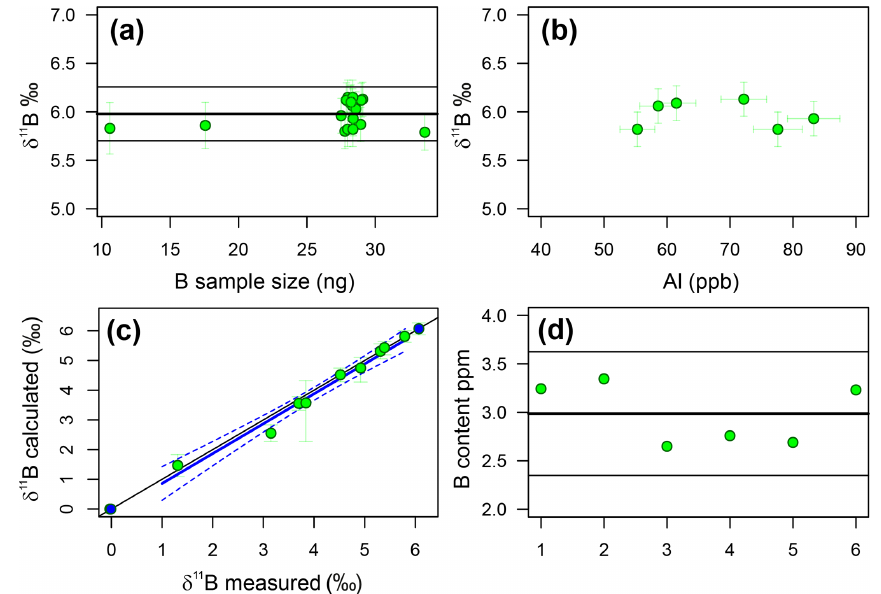
Figure 4. (a) The reproducibility of the TC460 diatom core catcher in-house standard. Samples of different concentration ( ∼ 10 to ∼ 30ngB) lie within error of the mean (5.98‰ ± 0.28‰, 2 σ ). This compares well to carbonates (2 σ = 0 . 20‰). (b) Aluminium concentration of the B fraction from TC460 (as ppb of the solution analysed for δ 11 B) shows no correlation with δ 11 B, likely suggesting there is no significant effect on mass fractionation for this level of Al. (c) The results of the standard addition experiment. The blue line is a least-squares regres- sion between the measured δ 11 B of each mixture (green circles) and the calculated δ 11 B of that mixture given known endmember values (endmembers shown as blue circles). R 2 = 0 . 97, p < 0 . 0001, slope = 1 . 01 ± 0 . 07 and intercept =− 0 . 15 ± 0 . 29. The 1:1 line is shown as a black line, and dotted blue lines show the 95% confidence limit of the regression. Note that the endmembers were not used in the regression. (d) B content in parts per million of six repeat samples of the diatom fraction of TC460. The black line indicates the mean value, and the grey lines show 2 σ of 2 . 99 ± 0 . 64ppm. Table 2. Treatment name and pH with δ 11 B and [B] for cultured T. weissflogii .